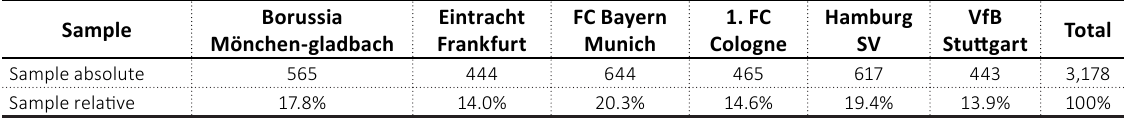
Table 2. Assessment of sporting performance Sample